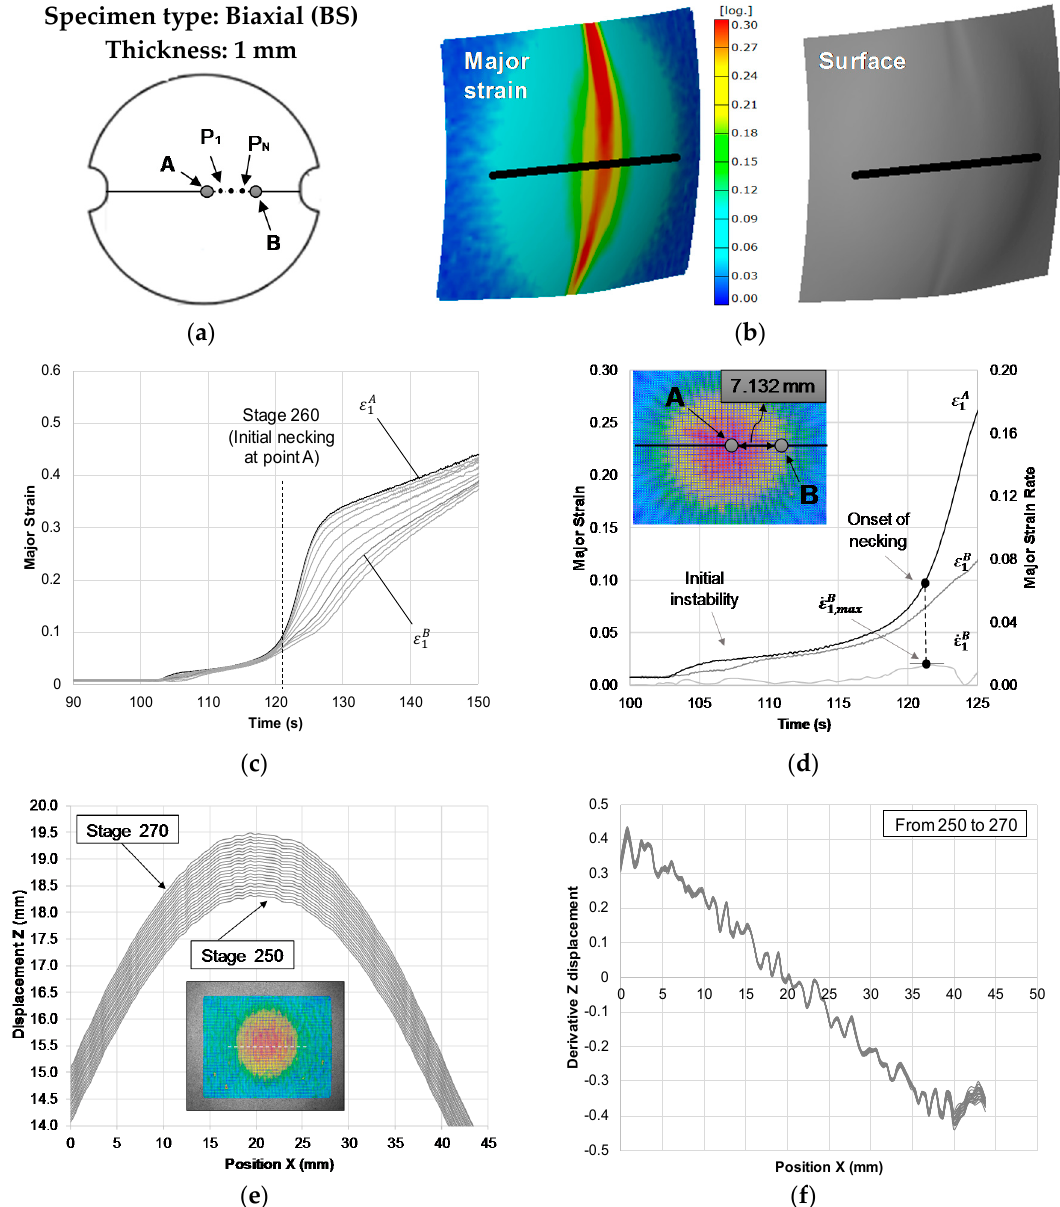
Figure 4. Application of the methodology to obtain the onset of necking strains for a biaxial strain (BS) Nakajima specimen of PC with 1 mm of thickness. ( a ) The geometry of the specimens and identification of the section perpendicular to the failure region and selected points along its length. ( b ) Major strain (left) and surface shape (right) of the specimens’ failure area obtained by the DIC system. ( c ) Experimental time evolution of the major strain along the points of the selected section. ( d ) Time-dependent approach application. ( e ) Z-displacement along the selected section. ( f ) The spatial derivative of Z-displacement along the selected section.